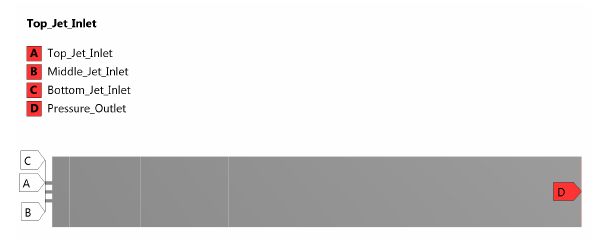
Figure 4: The boundary conditions for confined